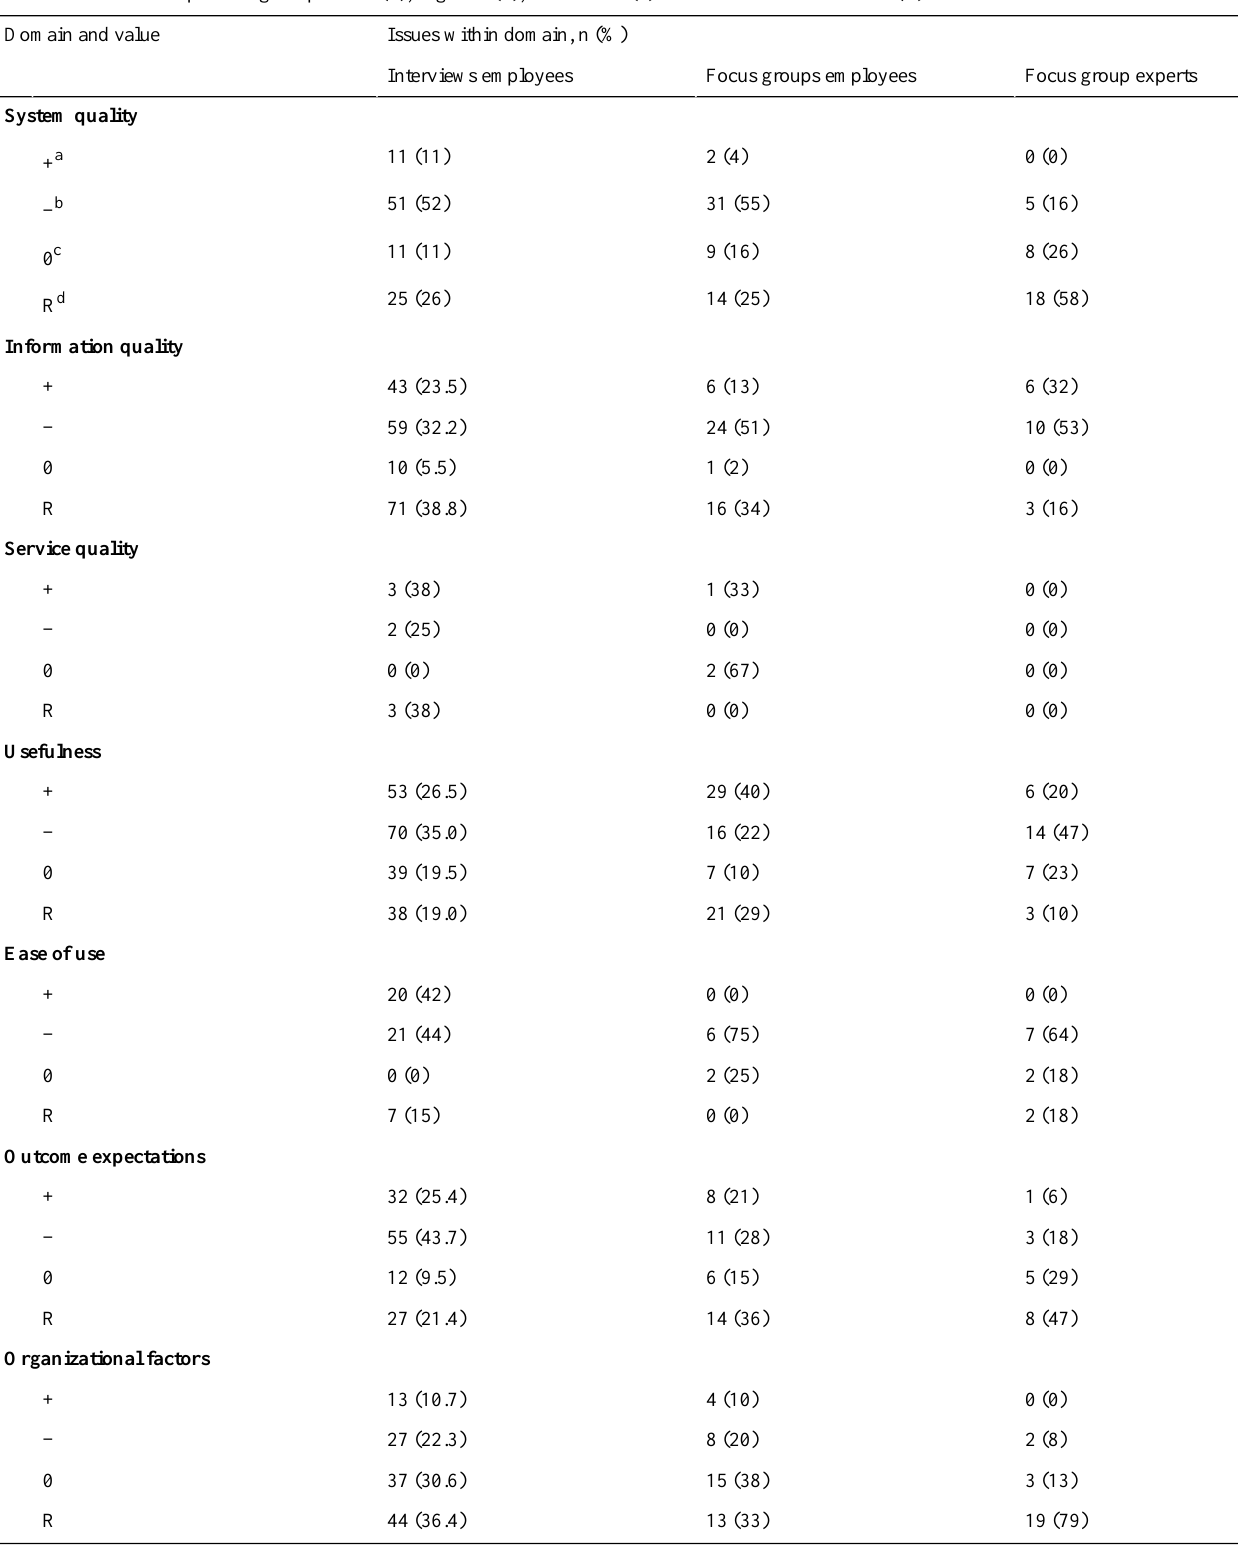
Table 4. Number and percentage of positive (+), negative (−), and neutral (0) issues or recommendations (R) within each domain. Issues within domain, n (%)Domain and